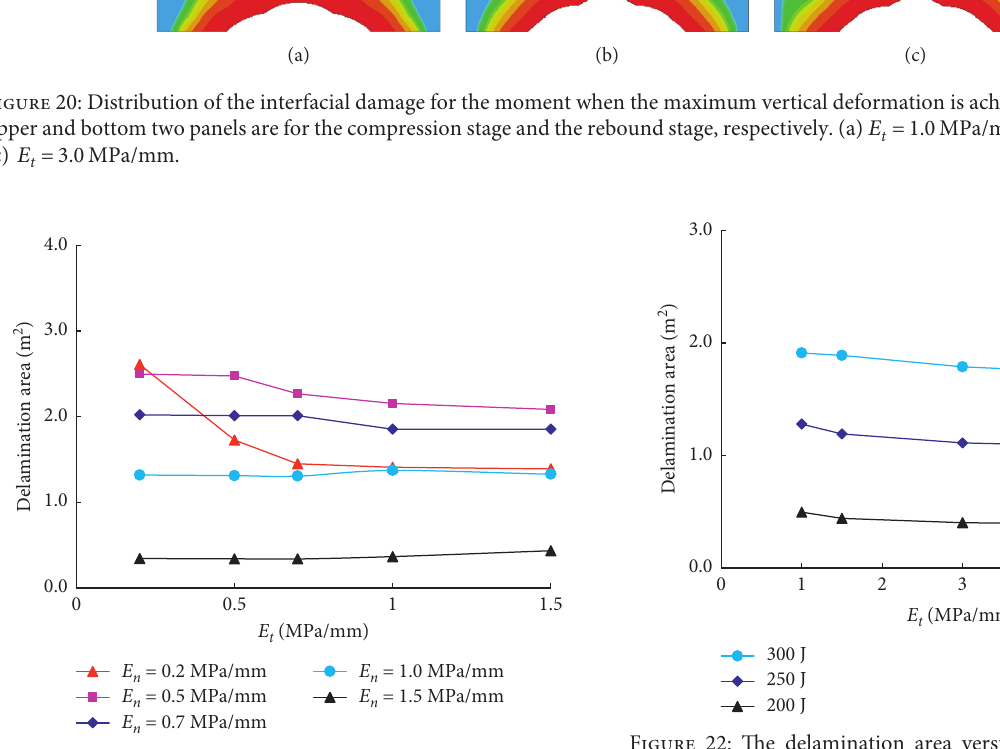
Figure 21: The delamination area versus E impact energy of 300J.